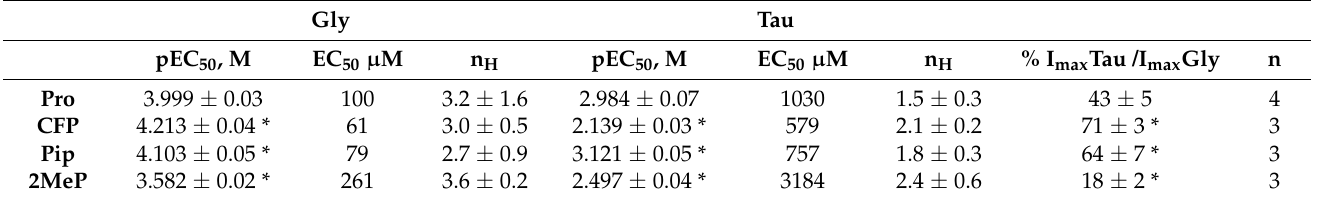
Figure 6. Concentration response curves for GlyR expressed in oocytes where P146 was substituted with Pro or Pro analogues using nonsense suppression. T/G = ITau/I max Gly. Parameters derived from these data are shown in Table 3. Data are mean ± SEM, n = 3–4. Table 3. Parameters derived from P146-substituted GlyR expressed in oocytes using nonsense suppression. Gly